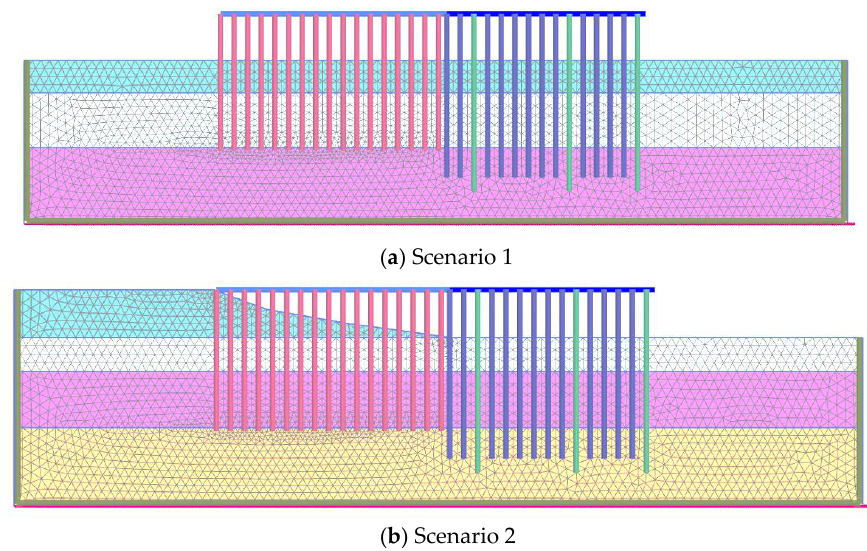
Figure 3. Typical FEA model of the PSW.